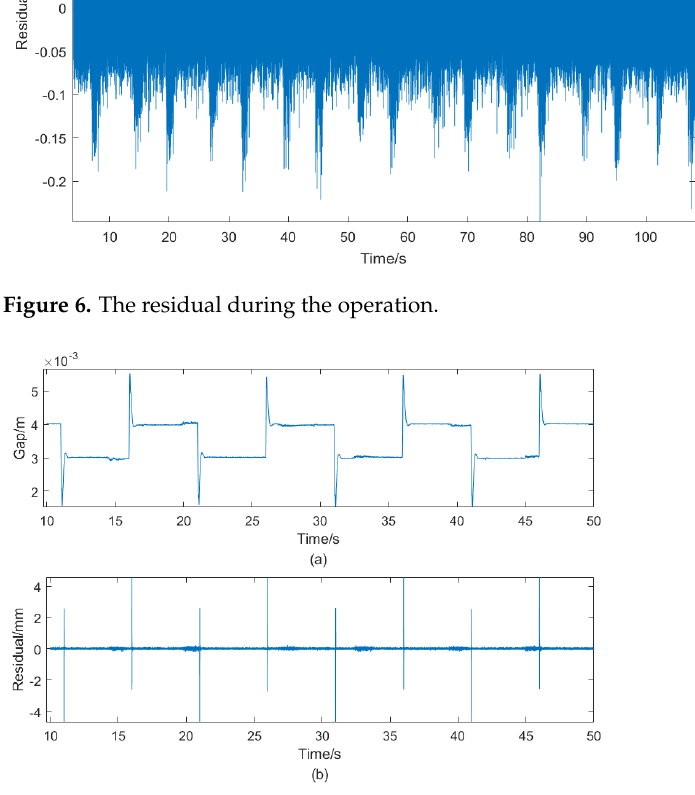
Figure 8. Gap of performance degradation and normal operation.